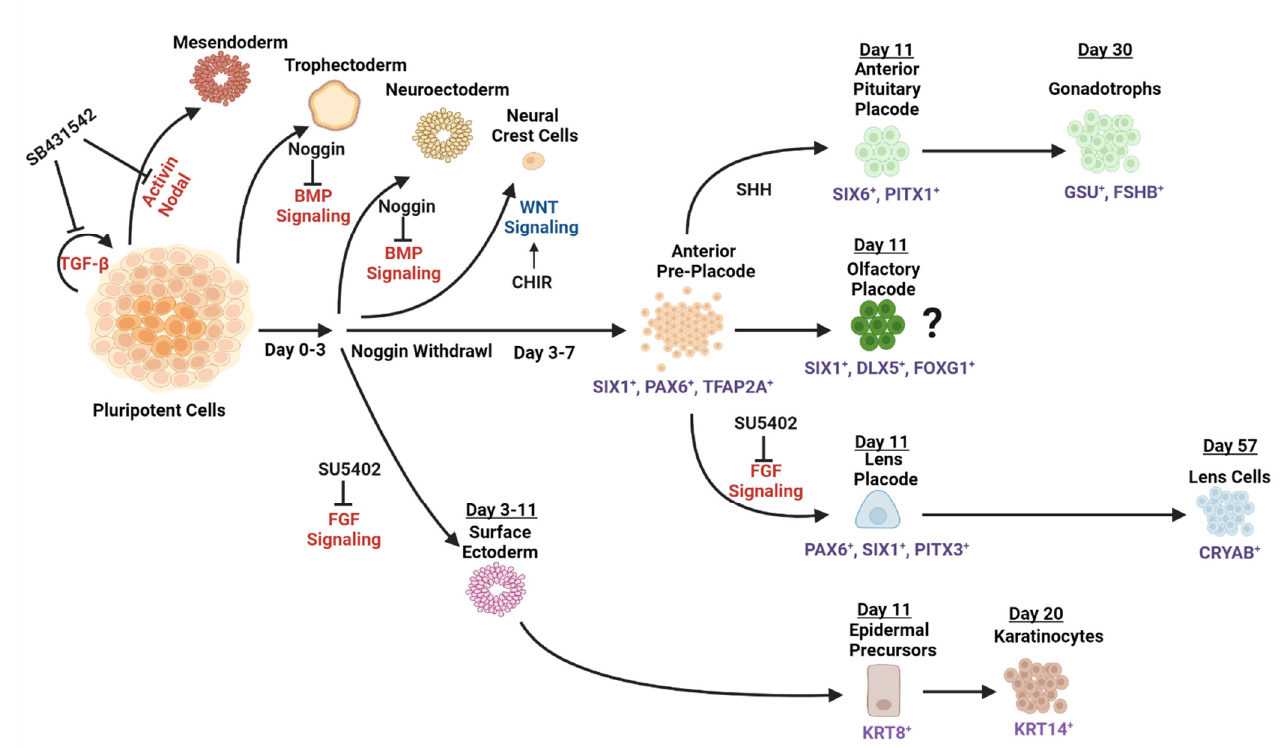
Figure 3. A summary model of the generation of anterior placodes from hPSCs using the dSMADi- based procedures. The diagram illustrates multiple cell fate decisions of the pluripotent stem cells, including those following Noggin- and SB431542-mediated phase of inhibition and TGF-β, Activin, and Nodal signaling inhibition [139]. Formation of anterior pre-placodal cell fate commitment can be subsequently induced through BMP activation. In contrast, epidermal precursors can be